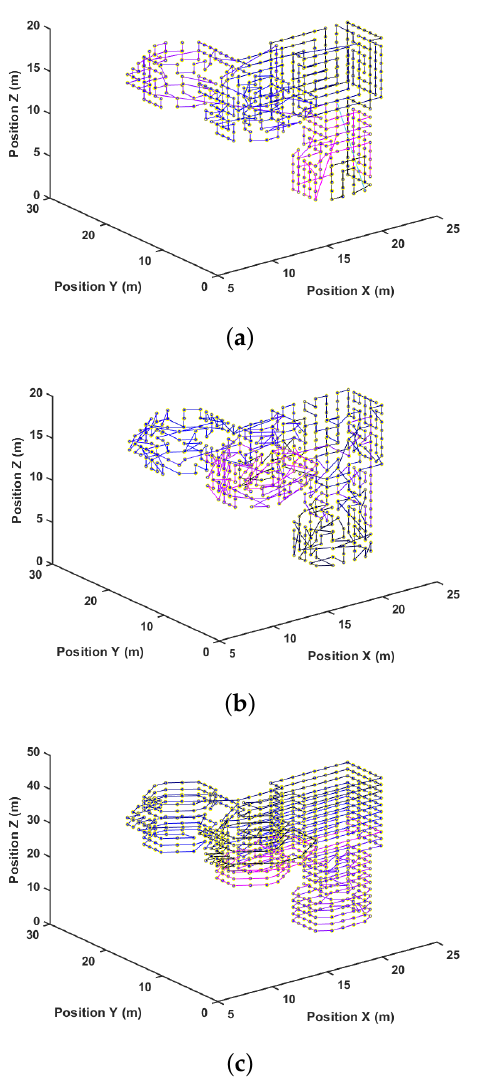
Figure 15. Path after solution for wm. ( a ) Greedy; ( b ) GA; ( c )